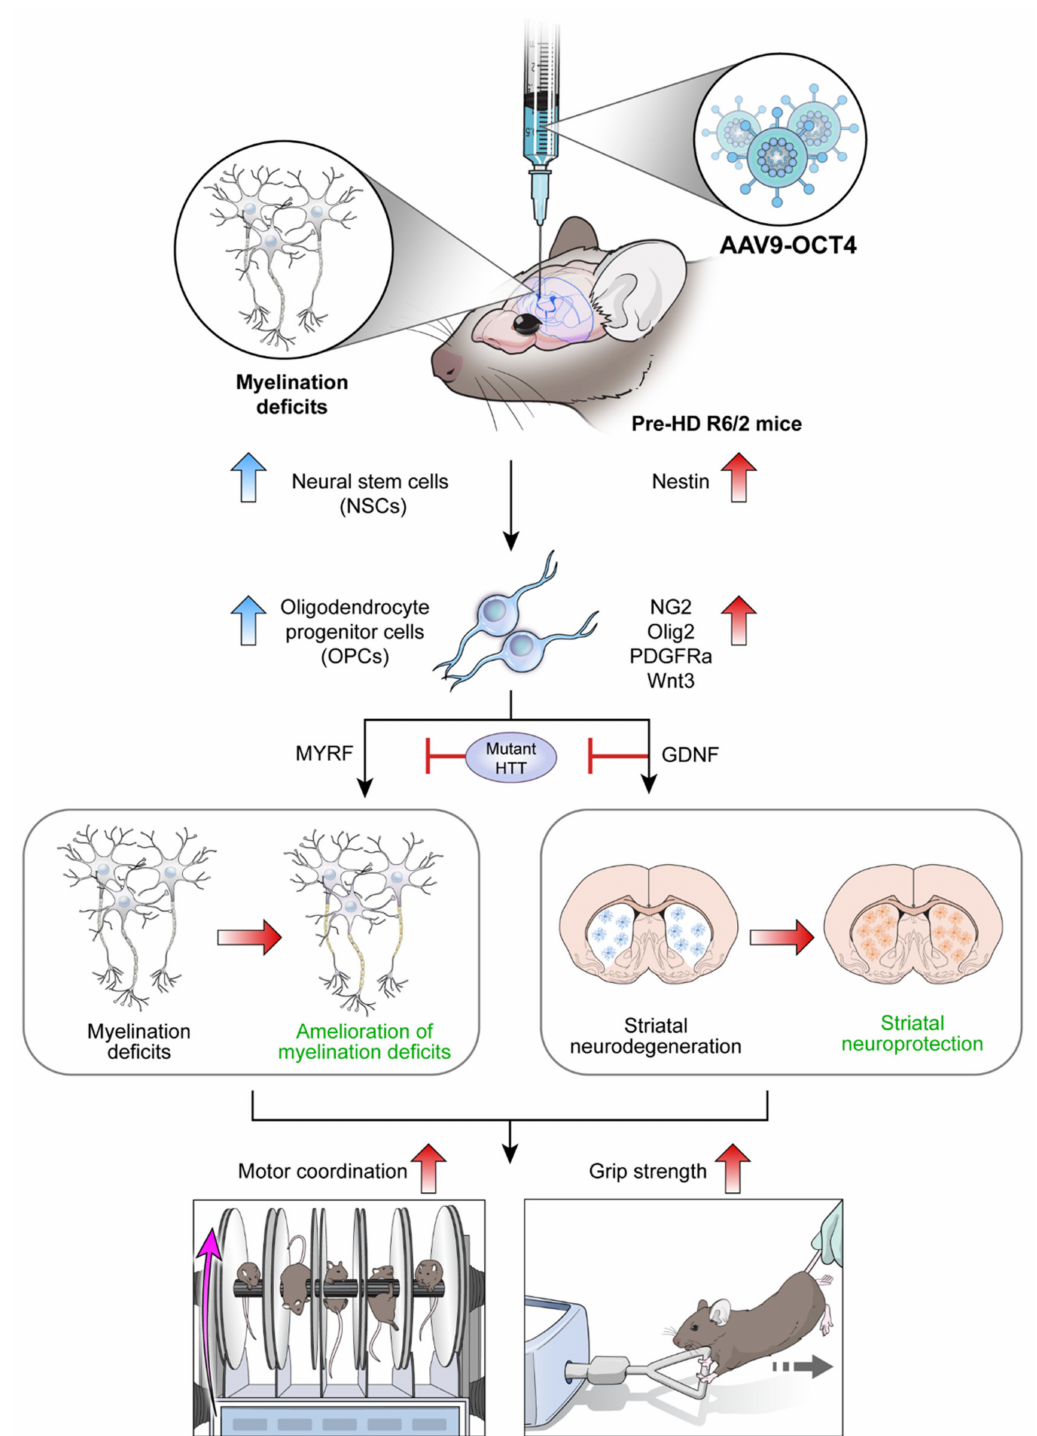
Figure 7. Scheme of in vivo expression of reprogramming factor OCT4 in R6/2 HD mice. Myelin deficits emerge in the corpus callosum at 4 weeks of age, pre-symptomatic (pre-HD) stage before remarkable GABAergic neuronal loss at late- symptomatic (late-HD) stage in R6/2 mice. In situ expression of reprogramming factor OCT4 induces NSC niche activation in the SVZ and changes cell fate specific to the microenvironment of HD from NSCs to OPCs. Particularly, MYRF and GDNF released by OCT4-induced OPCs seem to ameliorate myelination deficits and induce striatal neuroprotection, consequently improving behavioral performances such as motor coordination and grip strength in